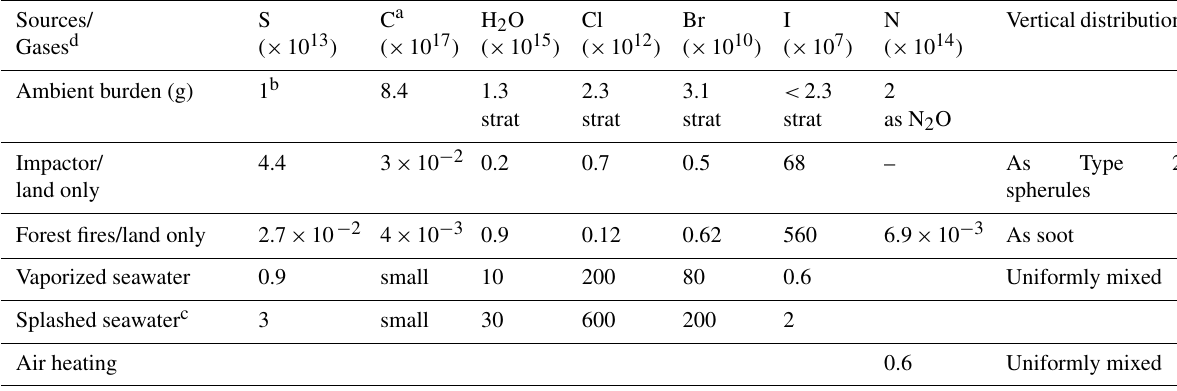
Vertical distribution